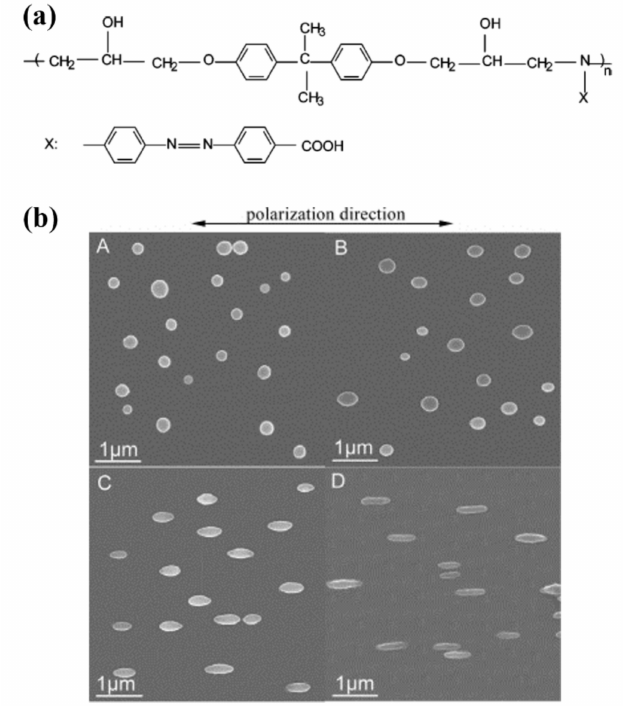
Figure 14. ( a ) Chemical structure of the polymer (BP-AZ-CA); ( b ) SEM images of colloidal spheres before irradiation ( A ) and after being exposed to interfering polarized Ar+ laser beams for different times: ( B ) 5 min, l / d = 1.31; ( C ) 12 min, l / d = 2.03; ( D ) 15 min, l / d = 2.35. Reprinted with permission from Reference [78]. Copyright 2005 American Chemical